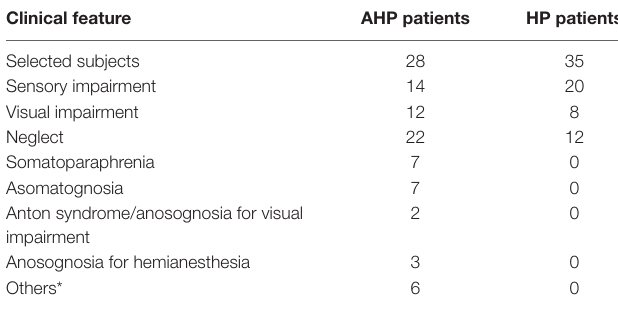
TABLE 1 | Demographical, clinical and radiological data of AHP and HP patients. Demographic, clinical and radiological data TABLE 2 | Clinical features of AHP and HP